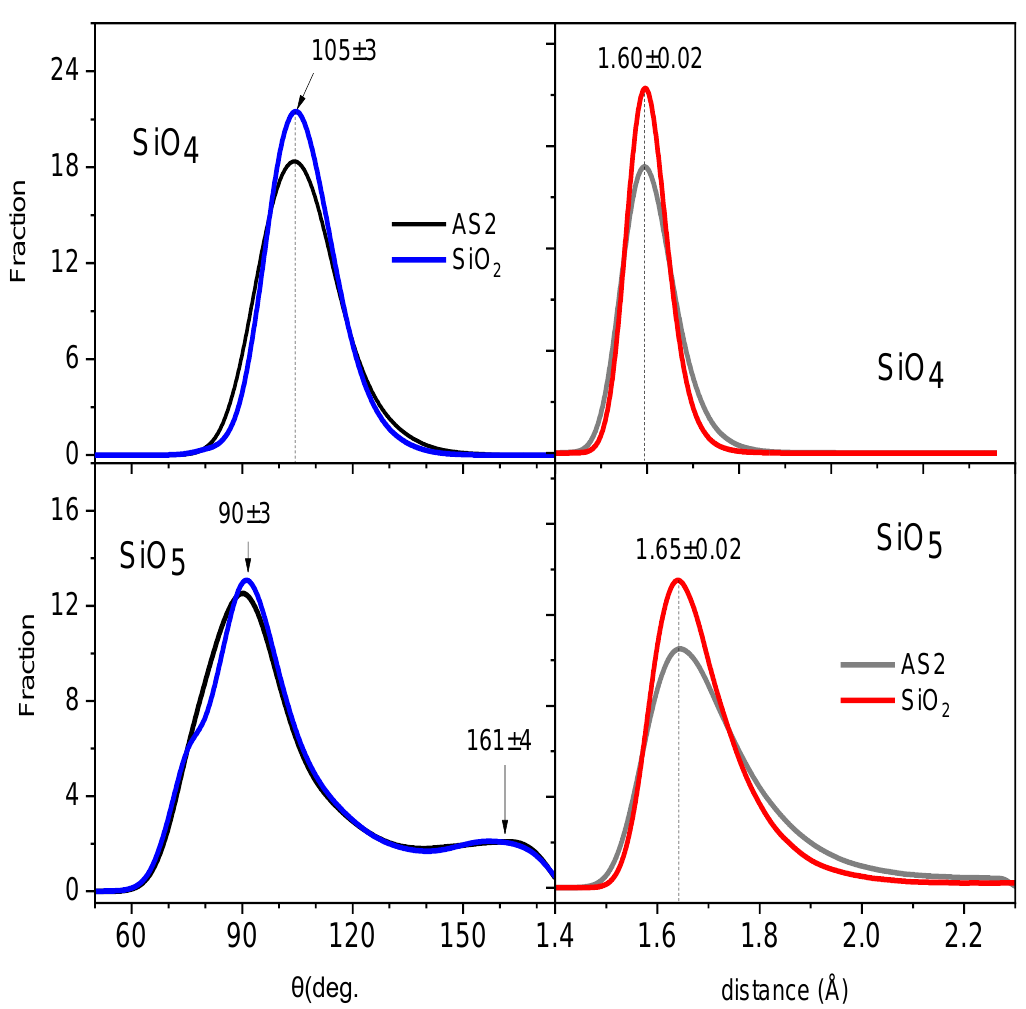
Figure 4. The comparison to the pair RDFs Si─O, Al─O between the pure SiO 2 , Al 2 O 3 , and AS2